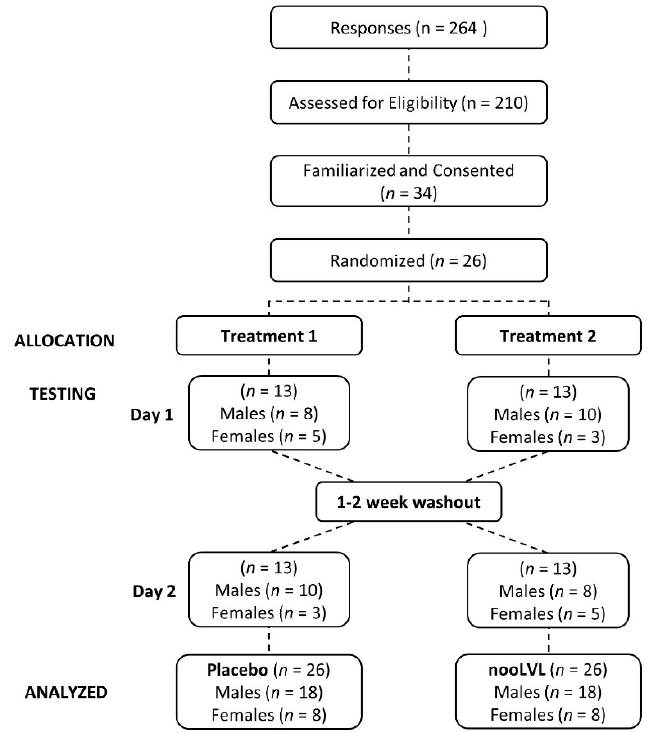
Figure 1. Consolidated Standards of Reporting Trials (CONSORT) diagram.